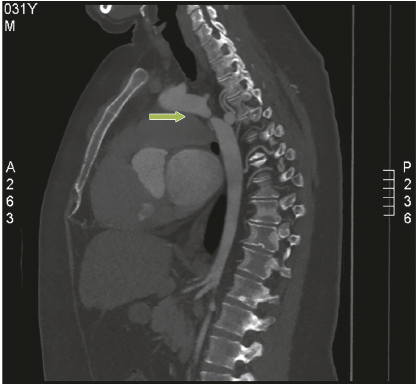
Figure 1: CT of left upper limb showing coarctation of the aorta at the isthmus.